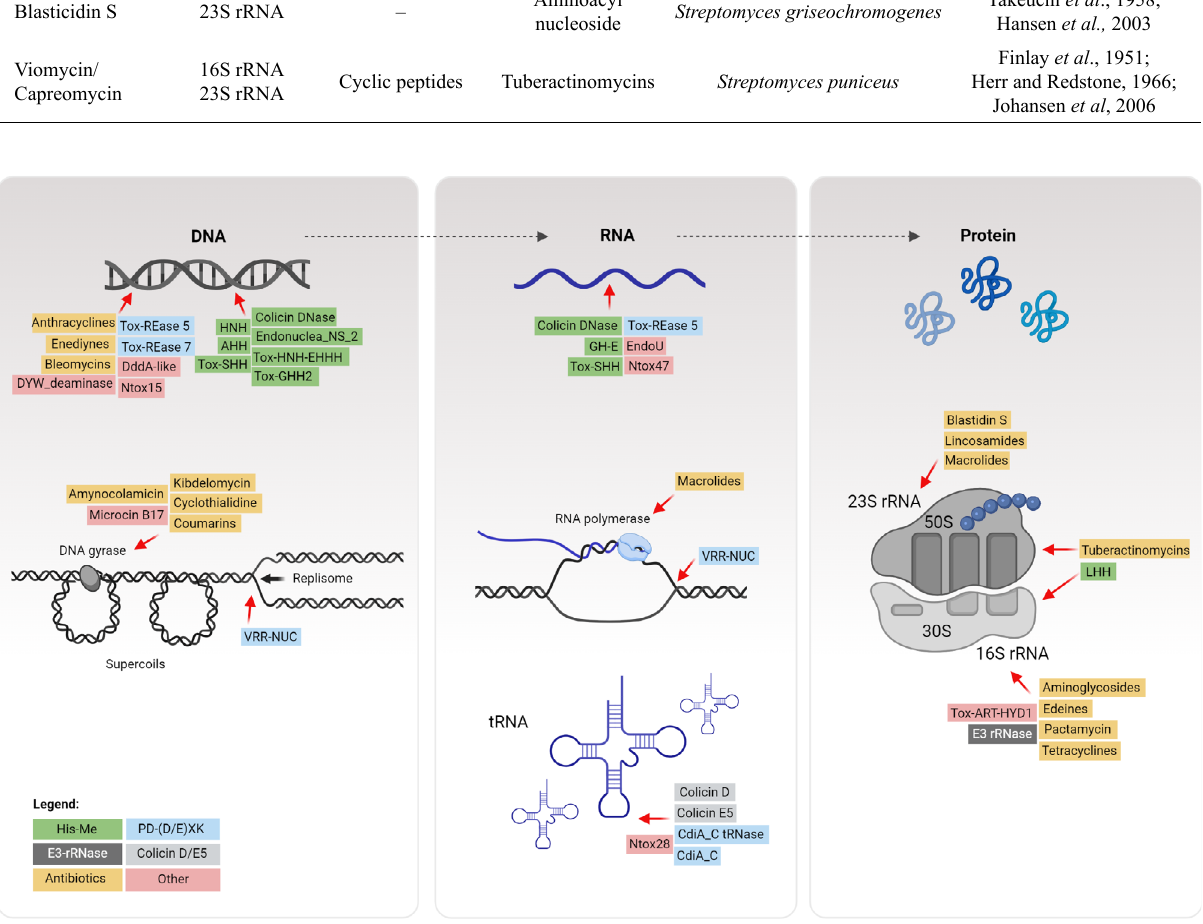
Figure 2 - Antibiotics, bacteriocins, and effectors targeting nucleic acids. Schematic representation of the information flow through the molecules of the central dogma (DNA, RNA and protein). Antibiotics, bacteriocins, and contact-dependent effectors targeting nucleic acids either by binding and inhibition or by enzymatic cleavage are indicated. Molecules were grouped according to their protein domains: His-Me finger (green), PD-(D/E)xK (blue), Colicin D/E5 (light grey), E3-rRNAse (dark grey), antibiotics (orange), others (light red). The complete list of molecules is described in Table 1. Created with